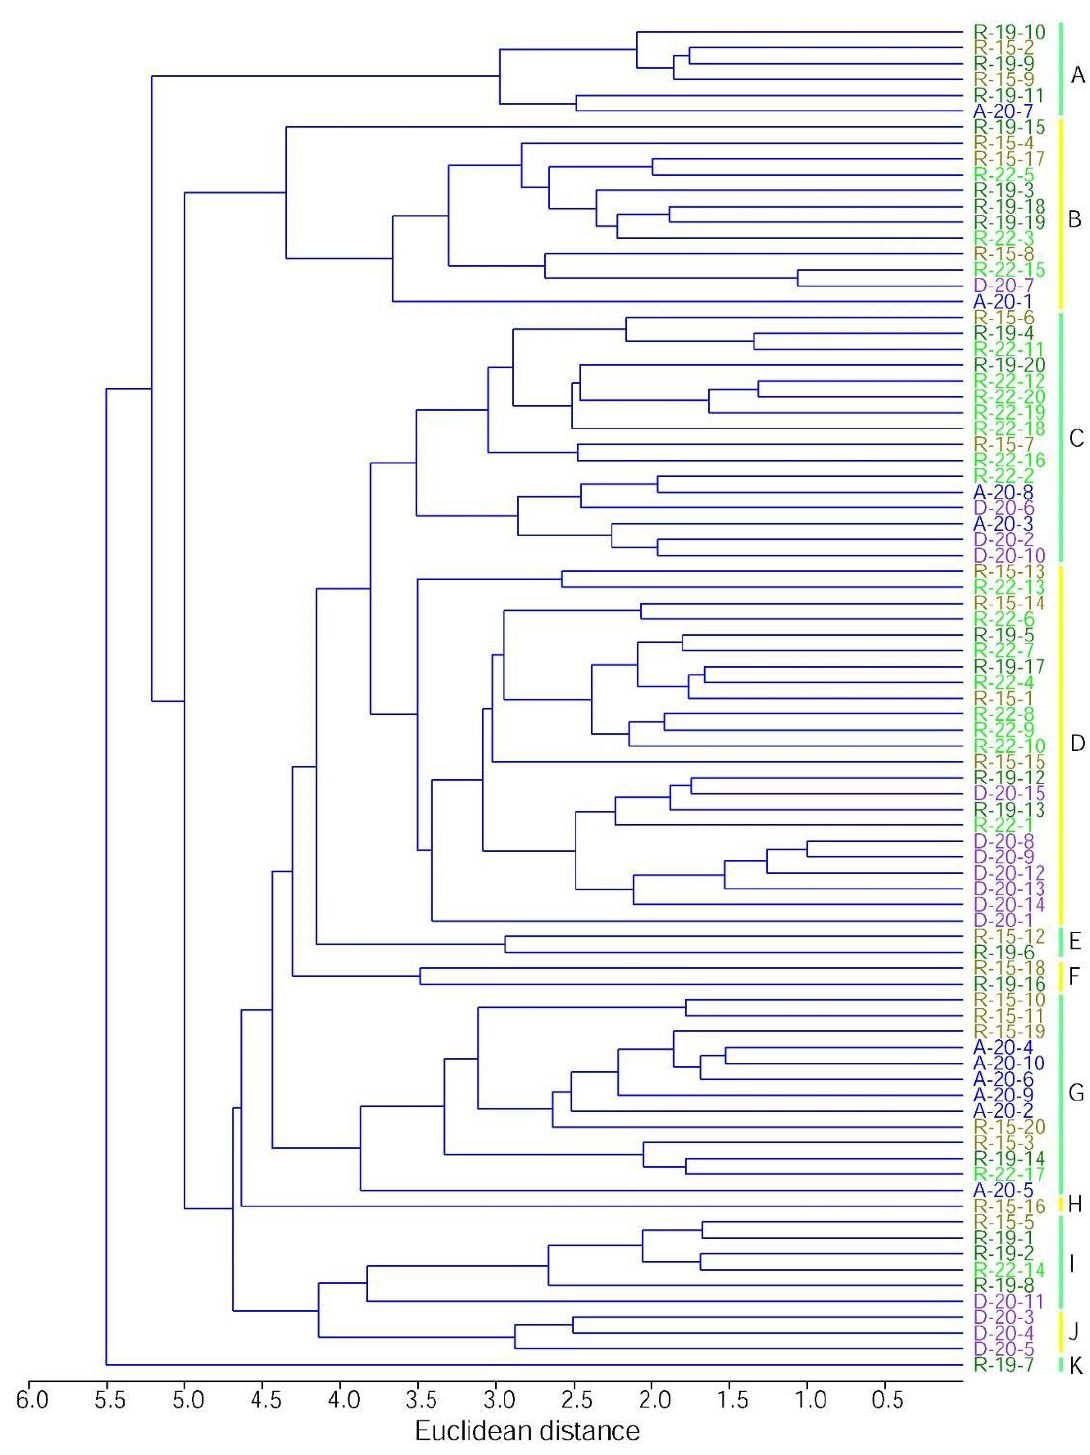
Figure 4. Dendrogram of communities with Aldrovanda vesiculosa , created using paired-group (UPGMA) algorithm and Euclidean distance. Different colours indicate different study years and lakes: Lake Rūžas (olive, green, and light green in 2015 (R-15), 2019 (R-19), and 2022 (R-22), respectively), Lake Apvardai (blue in 2020 (A-20)), and Lake Dysnai (dark purple in 2020 (D-20)). In relevé numbers, last two digits indicate sequence number of relevé (Supplementary Material, Table S1). Capital letters on the right refer to clusters explained in the text.